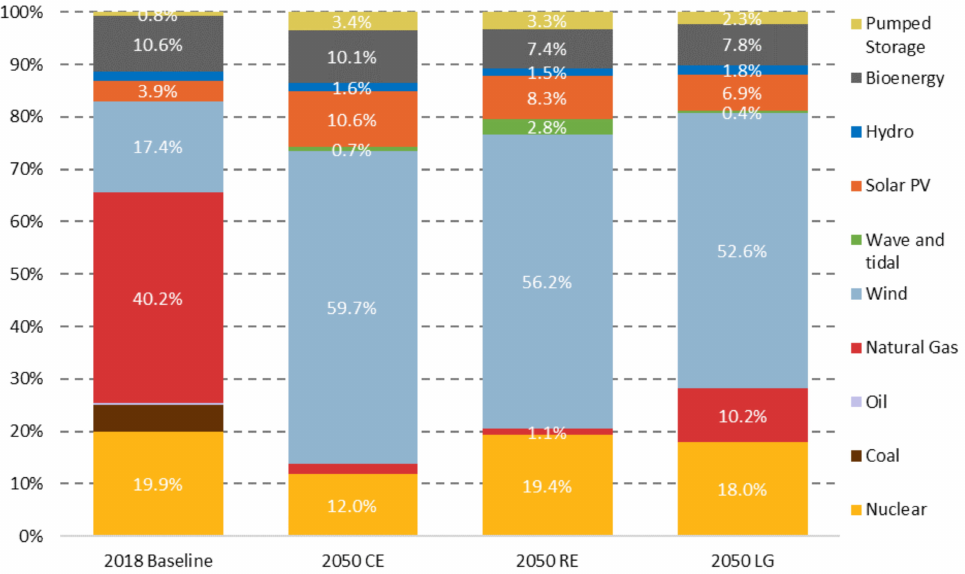
Figure 1. Electricity mix of UK in different scenarios used in LCA analysis. Data sources: